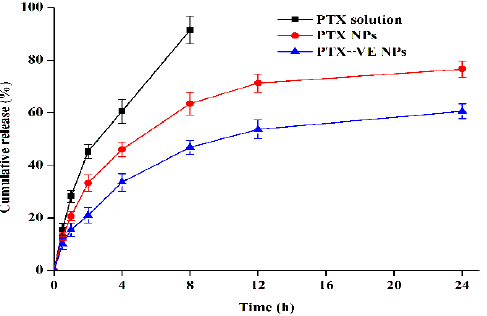
Figure 3. In vitro release profile of PTX from PTX solution, PTX NPs, and PTX-VE NPs, in phosphate buffered saline (0.5% of Tween 80 in PBS, pH 7.4), at 37 ± 0.5 °C (n = 3).